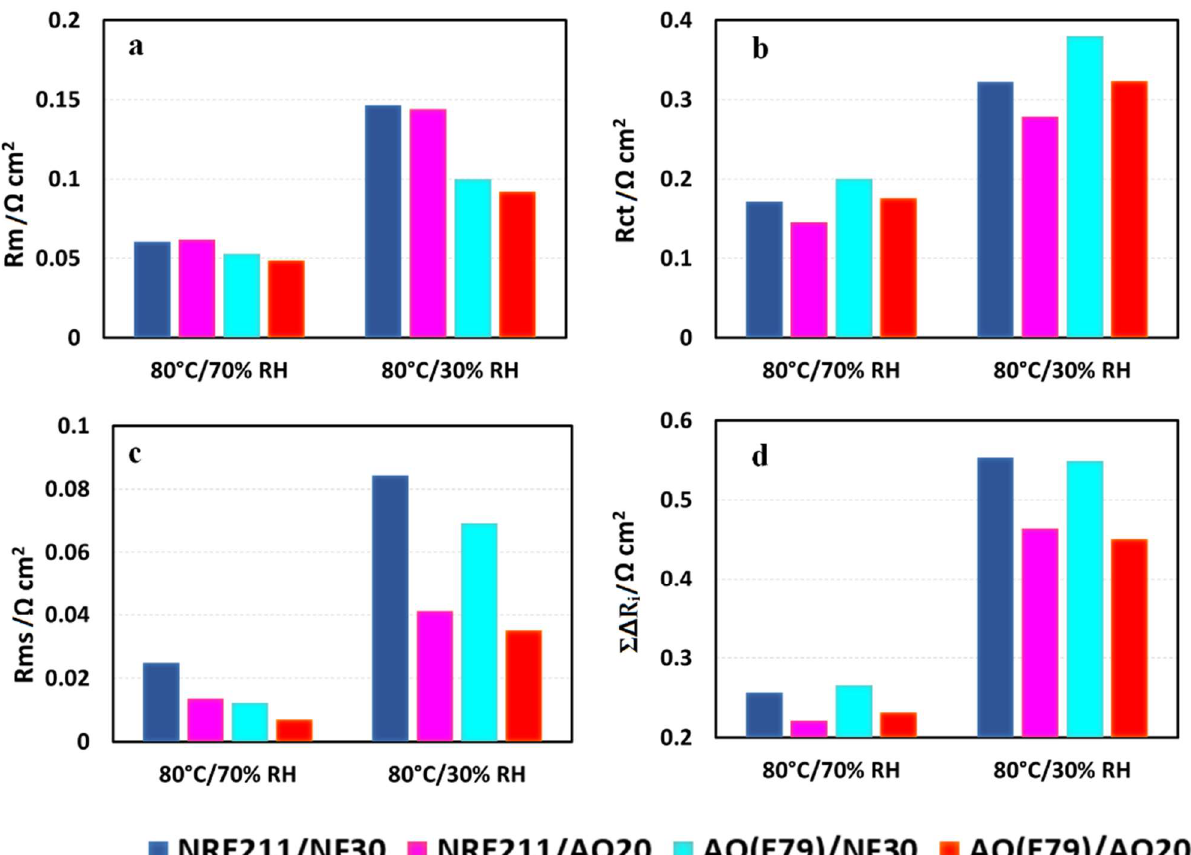
Figure 9. ( a ) Membrane resistance (R m ); ( b ) charge transfer resistance (R ct ); ( c ) mass transfer resistance (R mt ); and ( d ) overall resistances (Σ Δ R i ) of each MEA calculated from EIS data at 80 °C under 70% and 30% of RH. Table 3. Membrane resistances and relative conductivities calculated from both R Membr . and